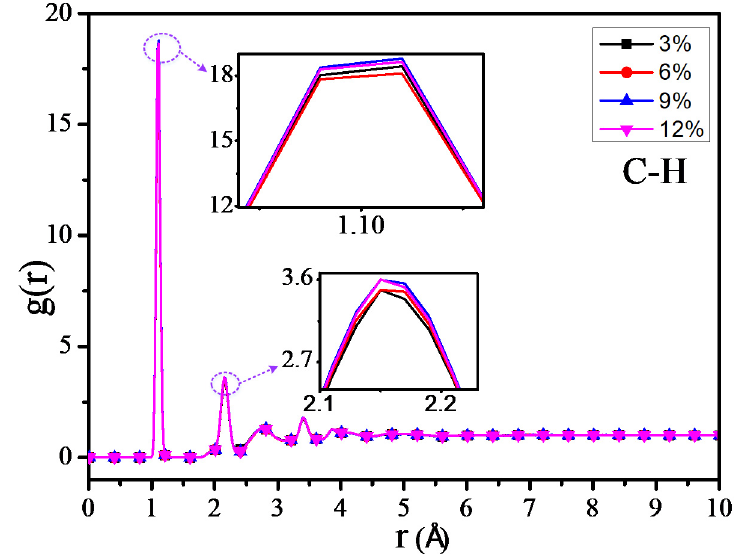
Figure 11. Radial distribution function (RDF) of C–H atoms of different models.